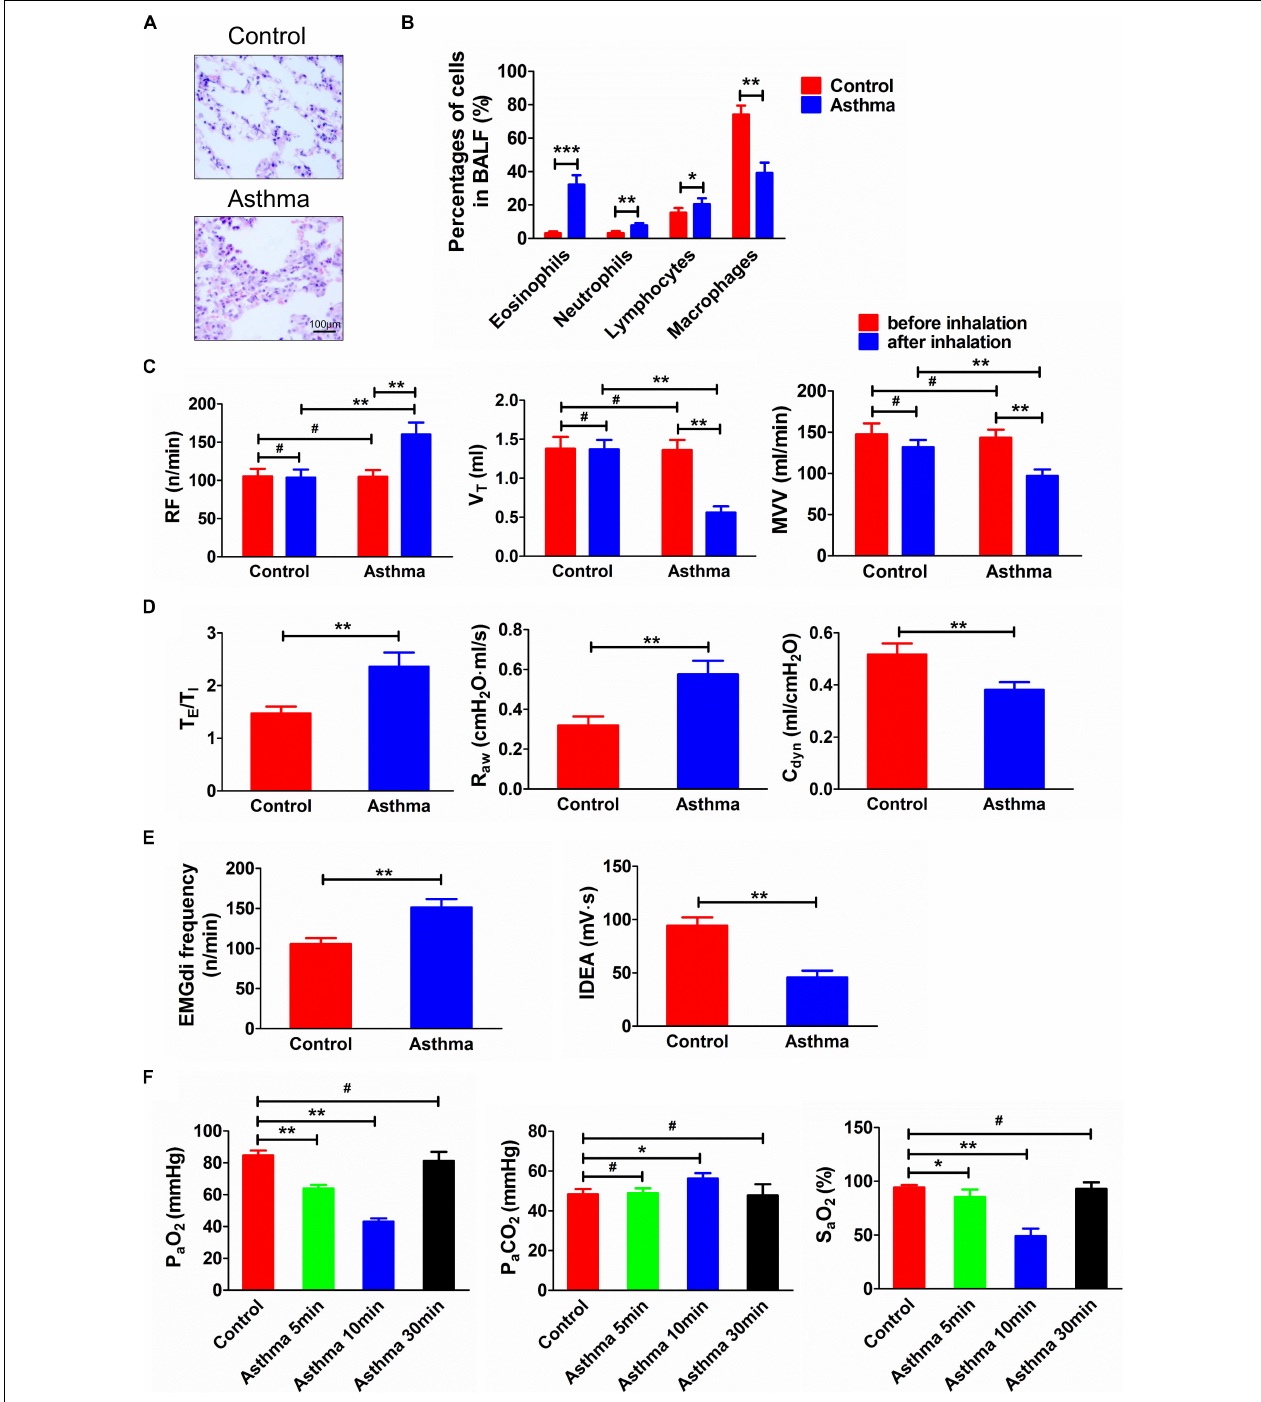
FIGURE 1 | (A) Histopathological changes of lung tissues in asthma and control rats. (B) Percentage of cells in BALF in asthma and control rats. (C) Changes of RF, V T , and MVV before and after challenge. (D) T E /T I , R aw , and C dyn in asthma and control rats. (E) EMGdi frequency and IDEA in asthma and control rats. (F) Changes of P a O 2 , P a CO 2 , and S a O 2 in control and asthma (5, 10, and 30 min) rats. After the rats were challenged, the lung function was deteriorated and the relevant indicators of ventilation function were significantly changed. Meanwhile, the airway inflammation, especially the eosinophils in BALF, was significantly increased. At the same time, as the duration of an asthma attack increased, arterial oxygen saturation was decreased. * p < 0.05, ** p < 0.01, *** p < 0.001, and # p > 0.05, respectively. n = 6 per group. BALF, bronchoalveolar lavage fluid; RF, respiratory frequency; V T , tidal volume; MVV, minute ventilation volume; T E /T I , expiratory time course/inspiratory time course ratio; R aw , airway resistance; C dyn , dynamic pulmonary compliance; EMGdi frequency, frequency of diaphragmatic electric activity; IDEA, integrated diaphragmatic electrical activity.